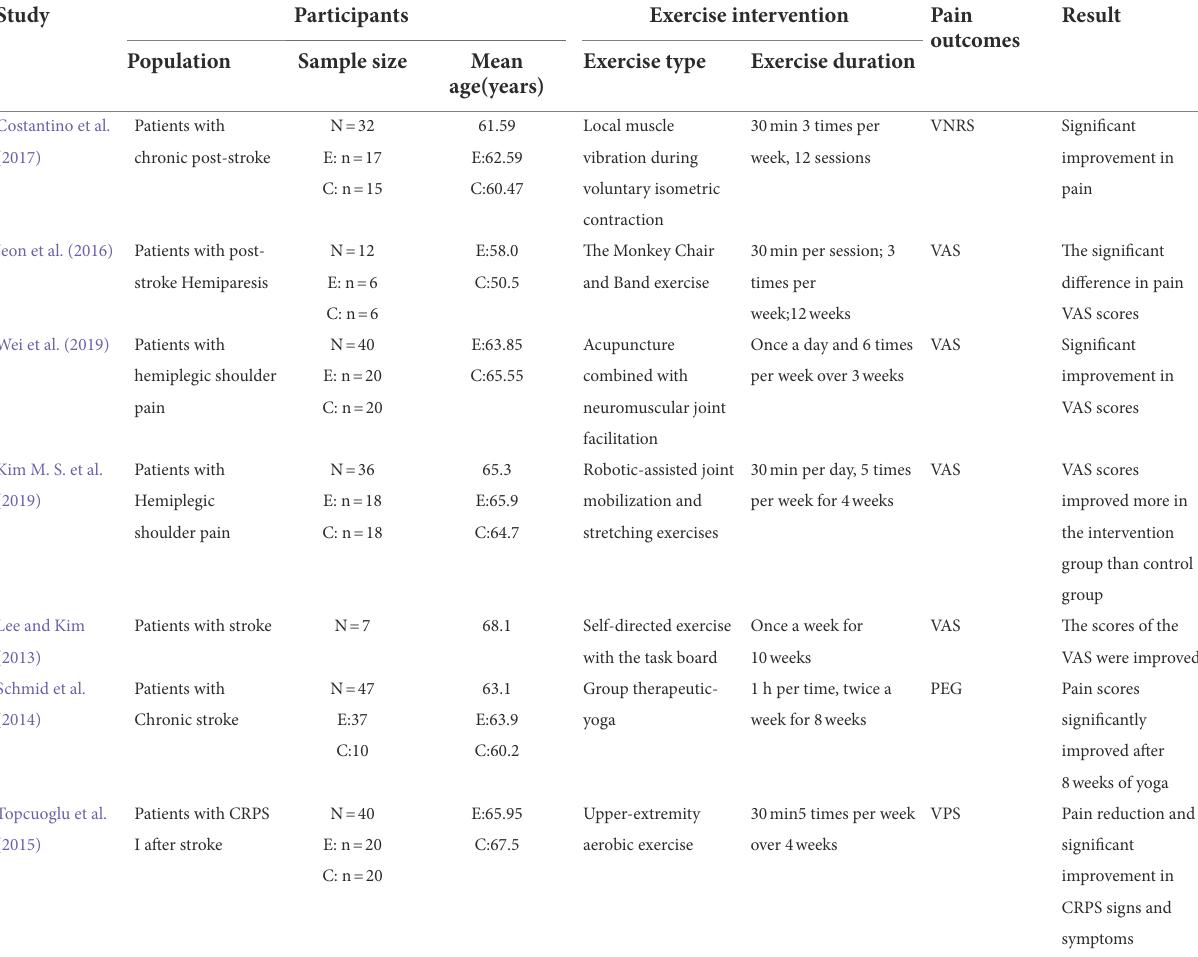
TABLE 1 General characteristics of studies on exercise for PSP. Study